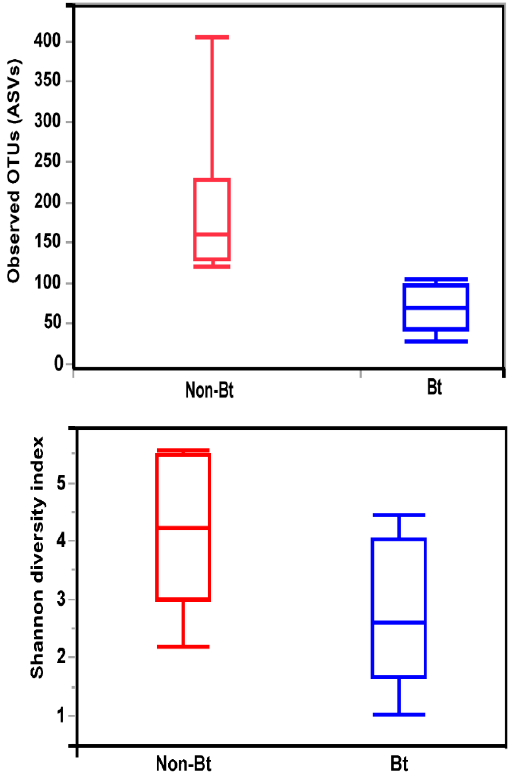
Figure 5. Alpha diversity measures (Observed OTUs and Shannon diversity) of the internal micro- biota of third stadium larvae of the bollworm, H. zea . Larvae were collected from non-Bt versus Bt cotton (WideStrike) in August 2018 (field season 2).